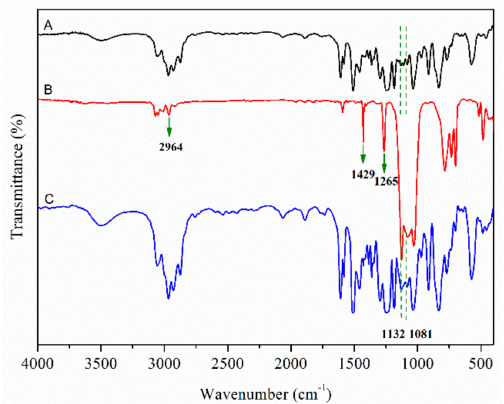
Figure 2. Fourier Transform Infrared (FTIR) spectra of ( A ) epoxy resin (E-51), ( B ) hydroxyl-terminated polymethylphenylsiloxane (HT-PMPS), and ( C ) silicone-modified epoxy resins (EPP).